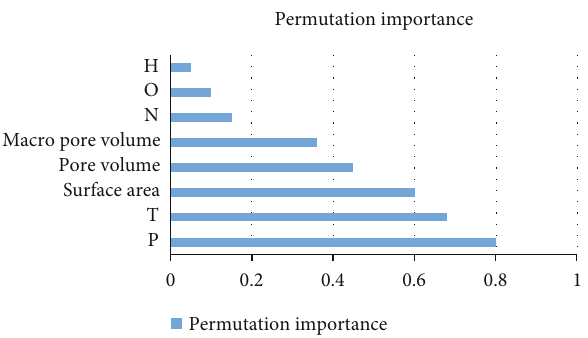
Figure 10: Feature importance analysis where the impact of each factor on the target output. The experiment illustrates the permutation importance on the